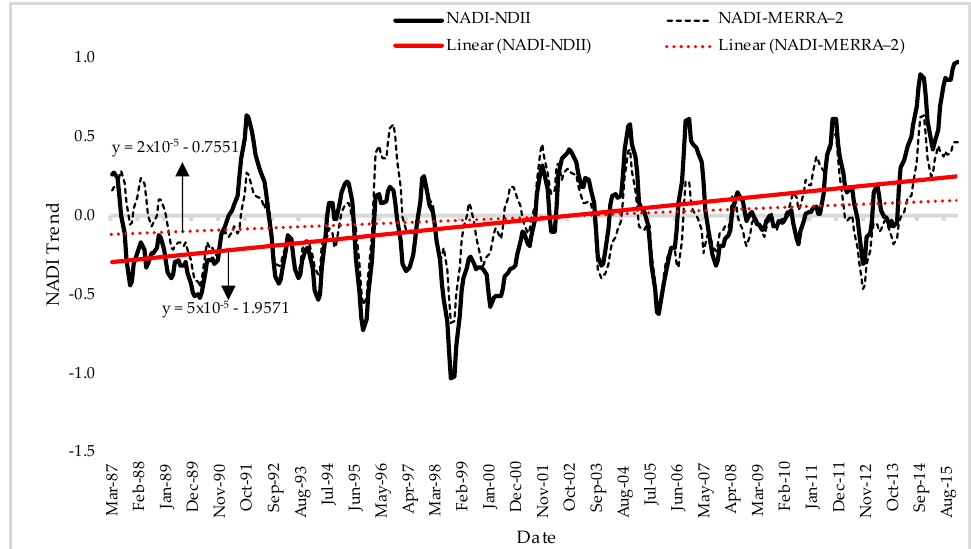
Figure 9. NADI times series and its best fit line for the Luvuvhu River Catchment.